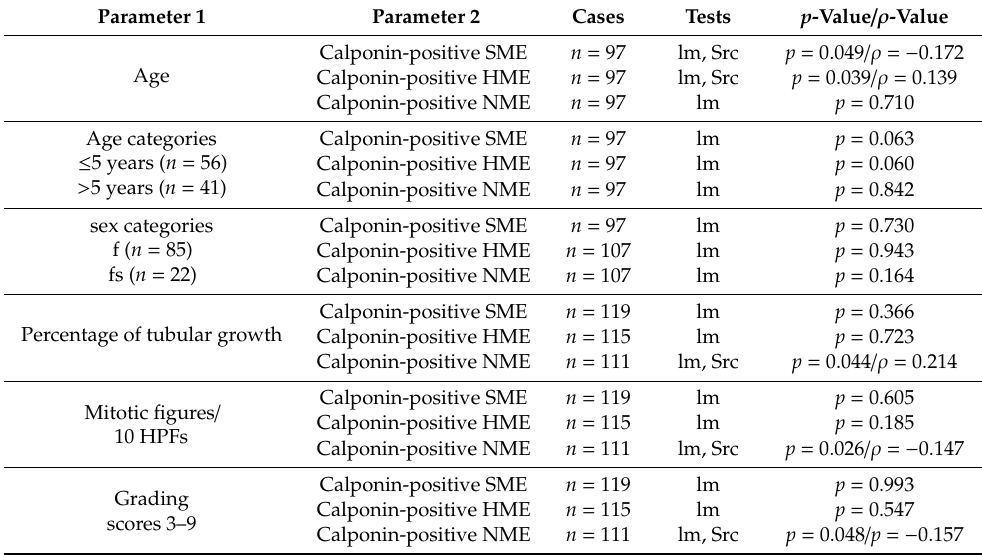
Table 2. Statistical Evaluations for Calponin Immunostaining of Pet Rabbit Mammary Carcinomas. Parameter